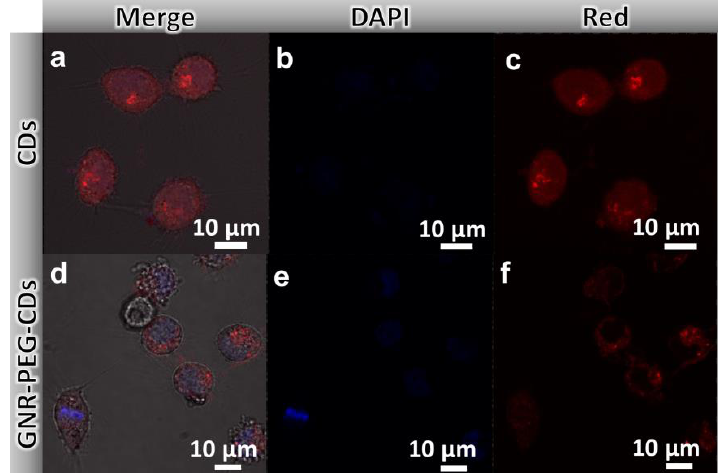
Figure 4. Confocal laser scanning microscopy (CLSM) images of HeLa cells incubated with CDs ( a , b , c )